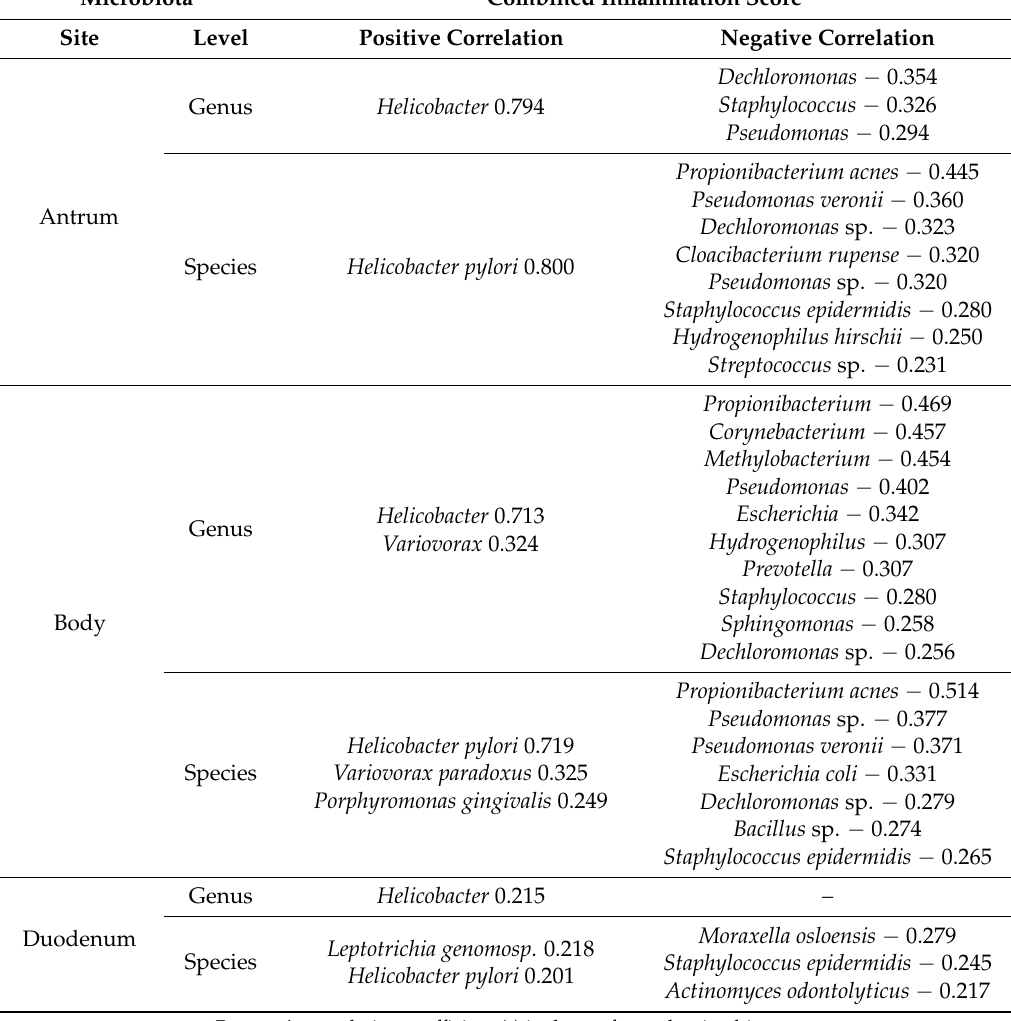
Table 2. Significant correlations between the relative abundance of microbiota and the combined inflammation